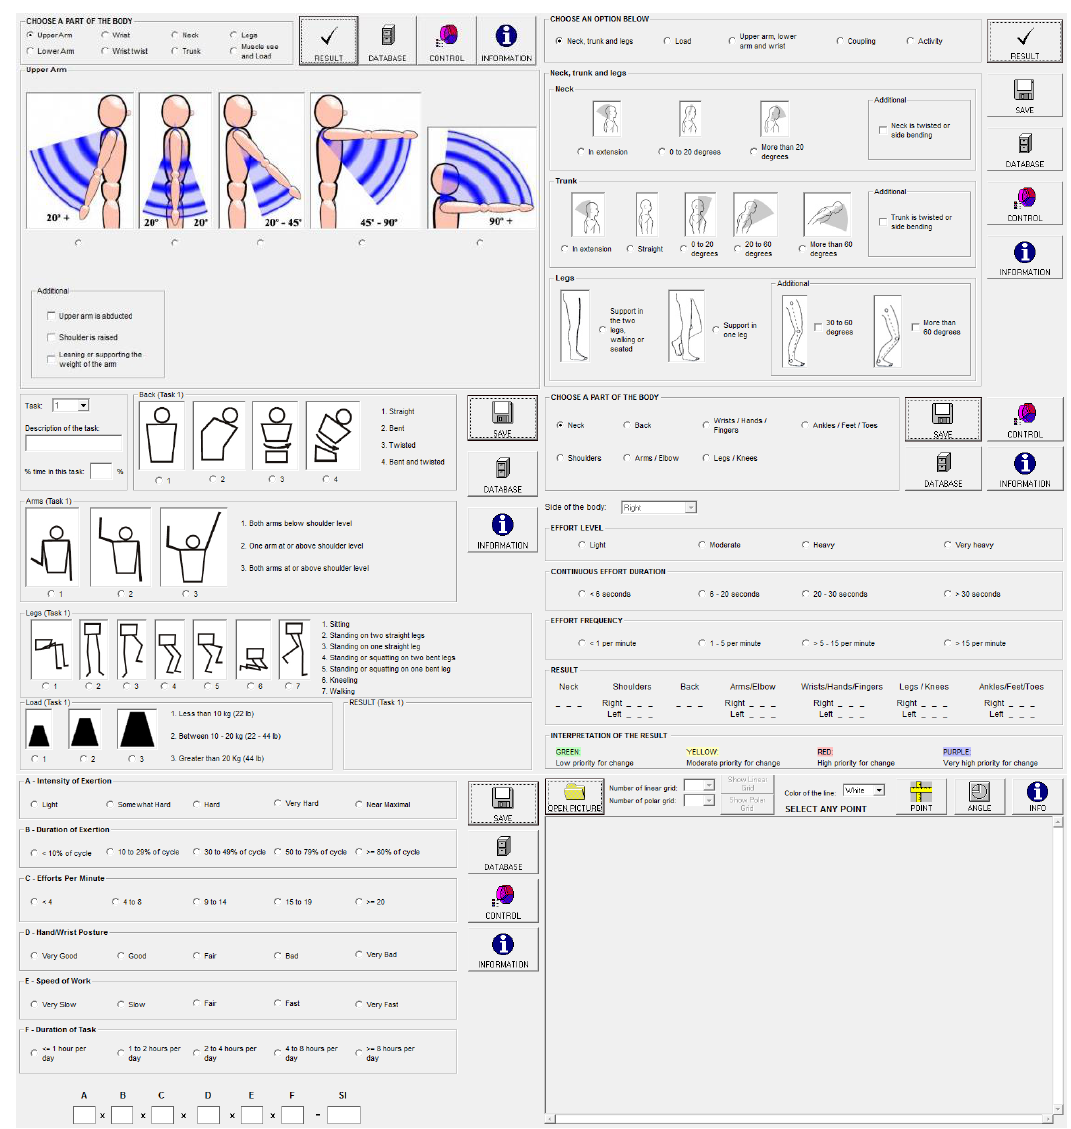
Figure 1. Used modules in Ergo Fellow as well as an Image Analysis tool. Source: (Ergo Fellow).